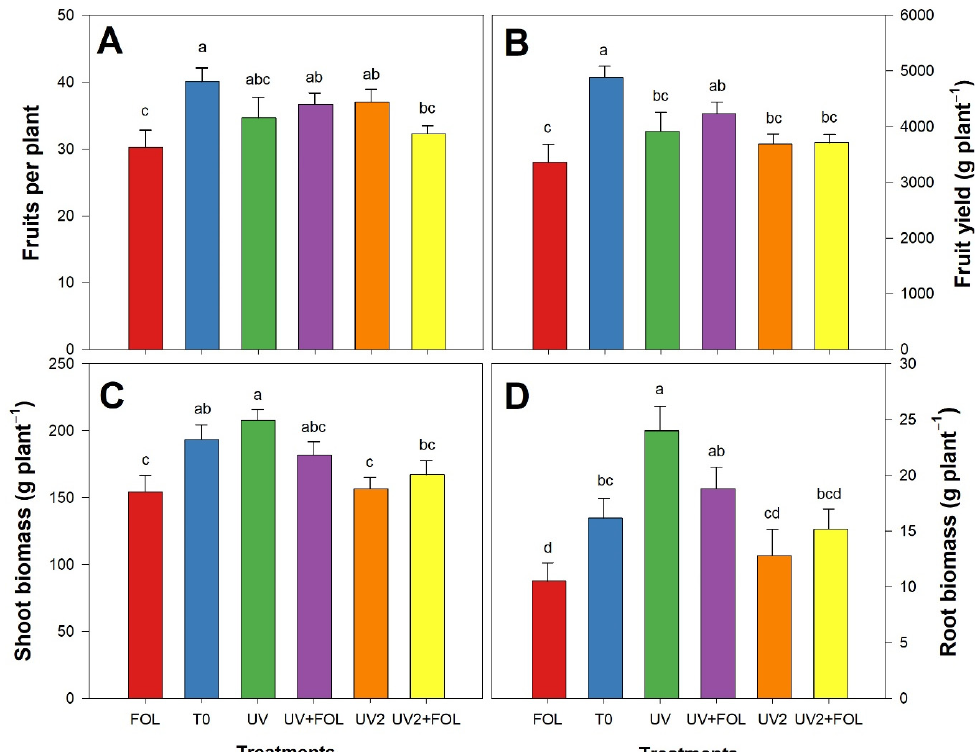
Figure 3. Impact of UV-A radiation on ( A ) Fruits per plant, ( B ) Fruit yield, ( C ) Shoot biomass, and ( D ) Root biomass of tomato plants inoculated with Fol obtained at 22 weeks after transplanting. Di ff erent le tt ers between treatments indicate signi fi cant di ff erences according to Fisher’s Least Signi fi cant Di ff erence test ( p < 0.05). n = 6 ± standard error. T0, negative control (tomato plants without UV-A radiation and without Fol inoculation); FOL, positive control (tomato plants only inoculated with Fol); UV, tomato plants supplemented with UV-A radiation through one LED lamp; UV + FOL, tomato plants supplemented with UV-A radiation through one LED lamp and inoculated with Fol; UV2, tomato plants supplemented with UV-A radiation through one LED lamp above the plant canopy plus one fi xed lamp at the bo tt om of the plants; and UV2 + FOL, tomato plants inoculated with Fol and supplemented with UV-A radiation through one LED lamp above the plant canopy plus one fi xed lamp at the bo tt om of the plants.